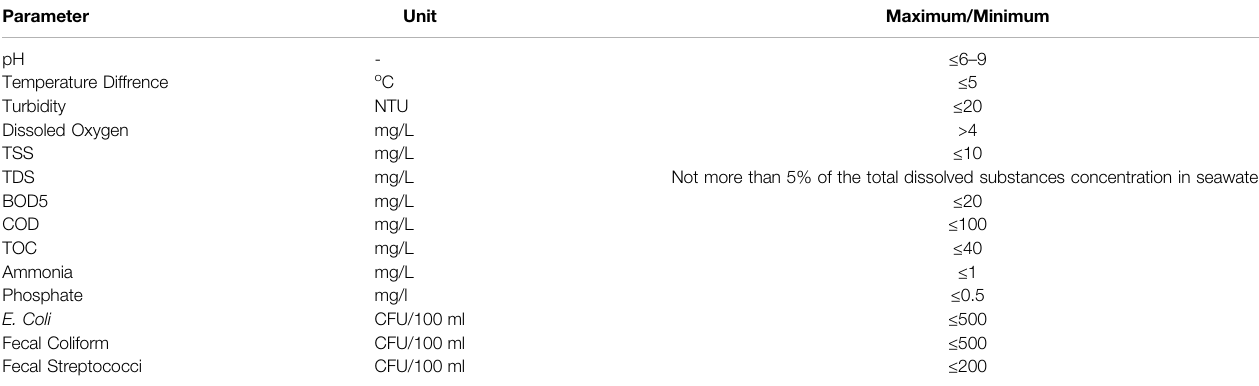
TABLE 2 | Guidelines for water quality discharged into Kuwait seawater (Kepa, 2014). Parameter